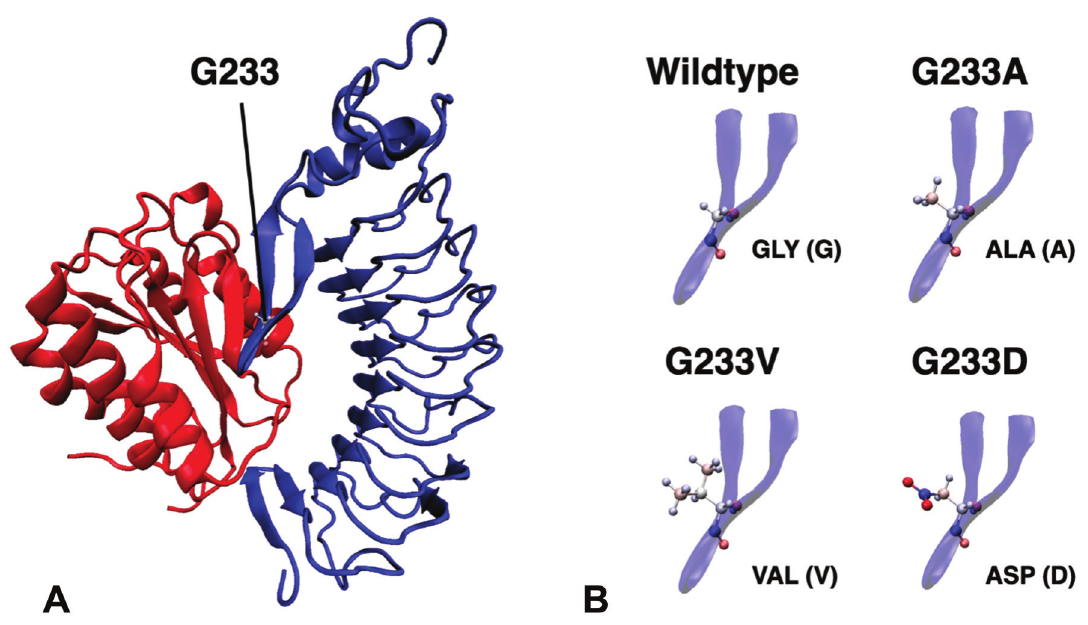
Fig. 1 Initial structure of VWFand GPIb ɑ in wild-type and the three mutants at G233. Panel A shows the position of G233 in N-terminus domain of GPIb ɑ ( blue ) binding with A1 domain of VWF ( red ). The initial positions of amino acid at 233 in wild-type (G) and the three mutants of G233A, G233V, and G233D are shown in panel B. The negatively charged carboxylate are shown in red, while the positively charged ammonium and guanidinium are shown in blue. TH Open Vol. 6 No. 4/2022 © 2022. The